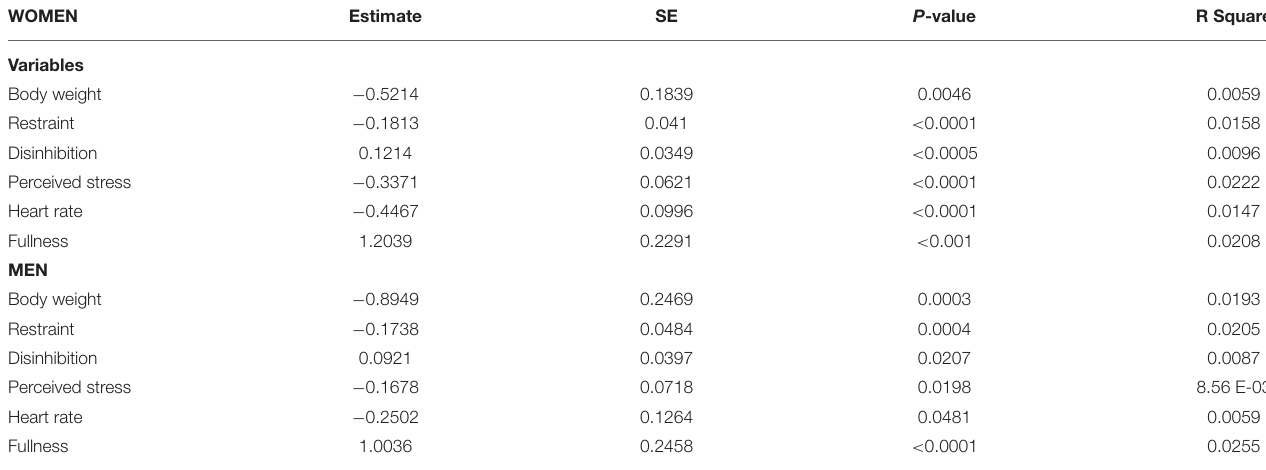
TABLE 3 | Correlations between percent body weight loss and baseline level of relevant